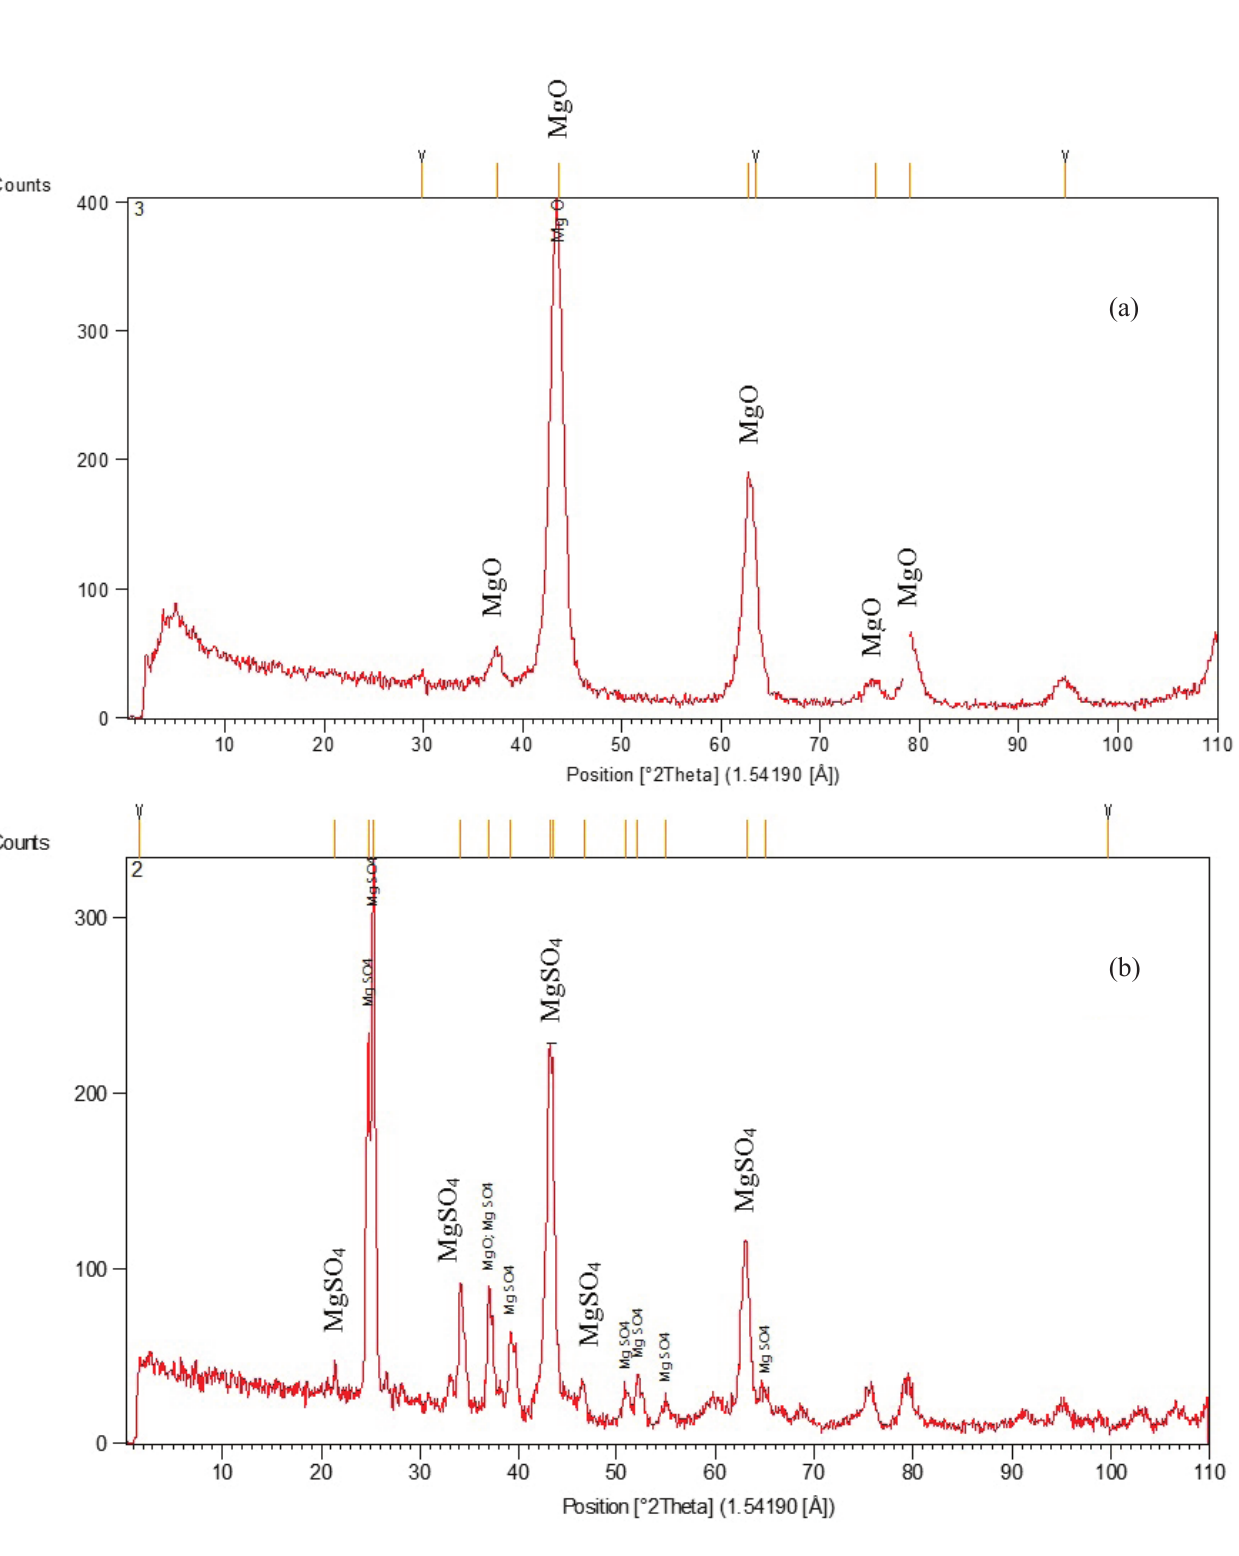
in the packed bed 2